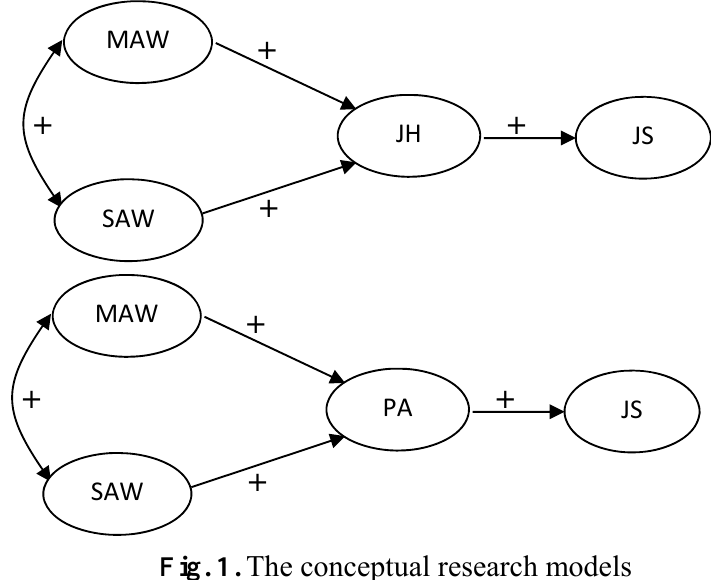
Fig. 1. The conceptual research